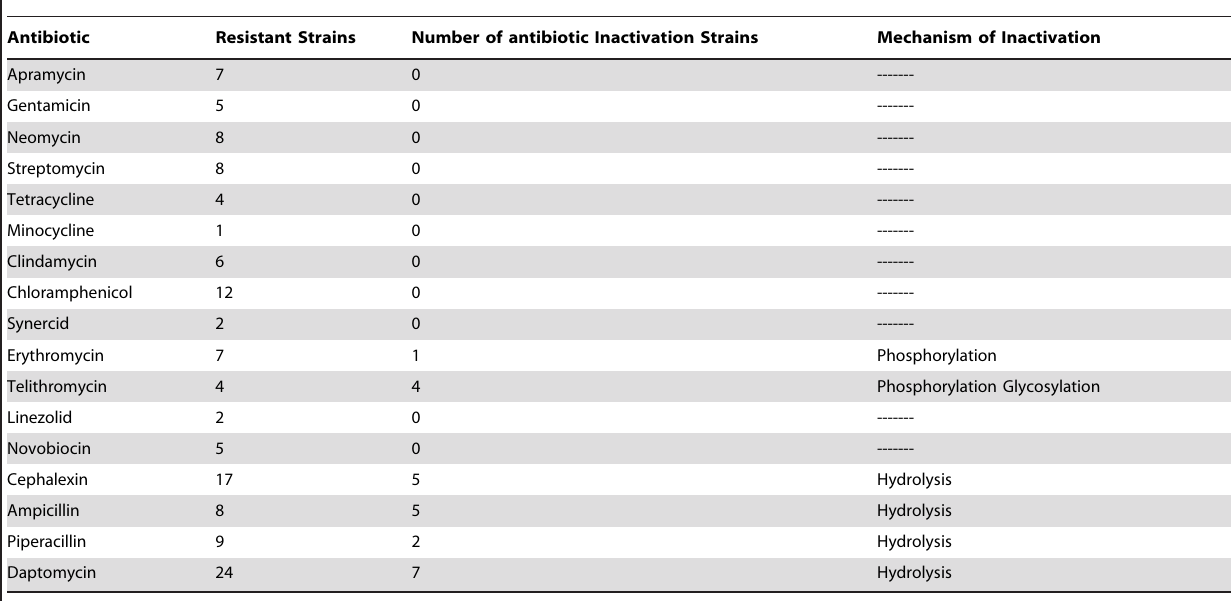
Table 1. Summary of Antibiotic Inactivation Studies for Gram-positive Isolates.